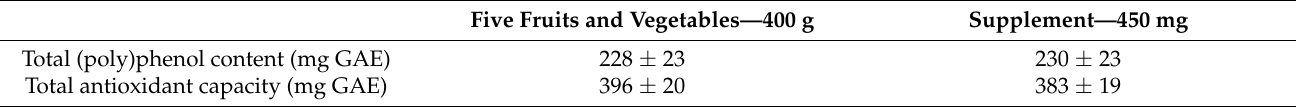
Table 1. Comparison of total (poly)phenol content (mg GAE) and antioxidant capacity between 400 g of five servings of fruits and vegetables and a daily dose of 450 mg of the test supplement. Values are reported as mean ± SD ( n = four different production batches of the supplement).